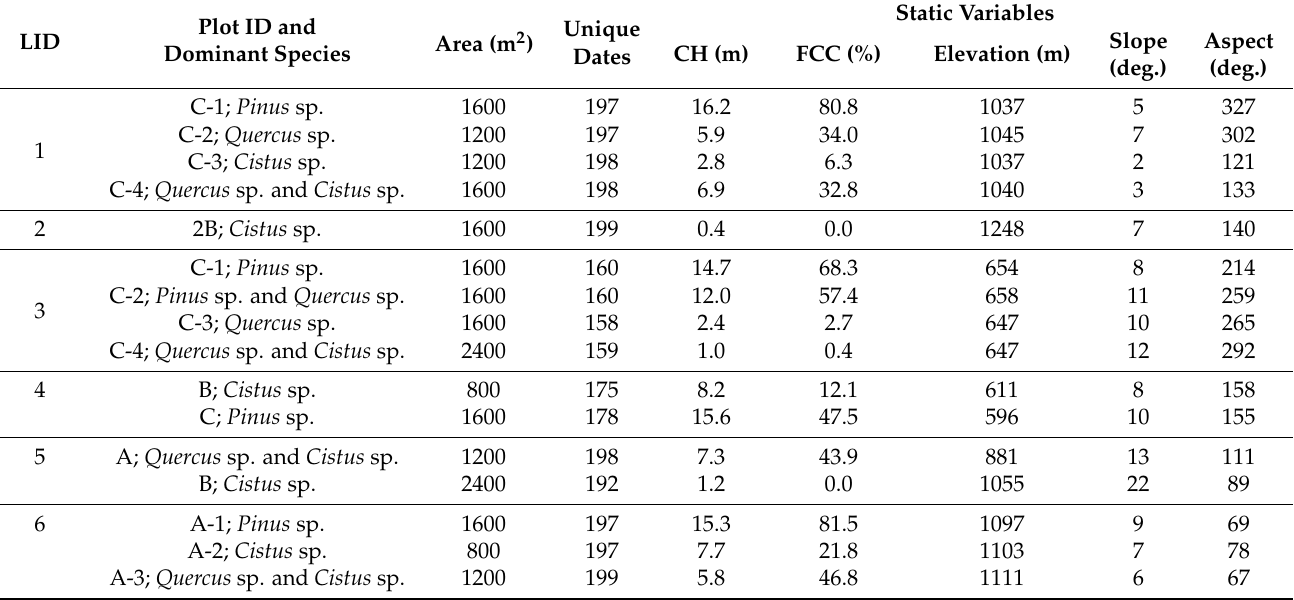
Table 3. Number of unique sampling dates matched with satellite images (2016–2020 period) for each location ID (LID) and plotted together with the static variables (CH—canopy height, FCC—forest fractional cover, elevation, slope, aspect) computed from PNOA Aerial Laser Scanning